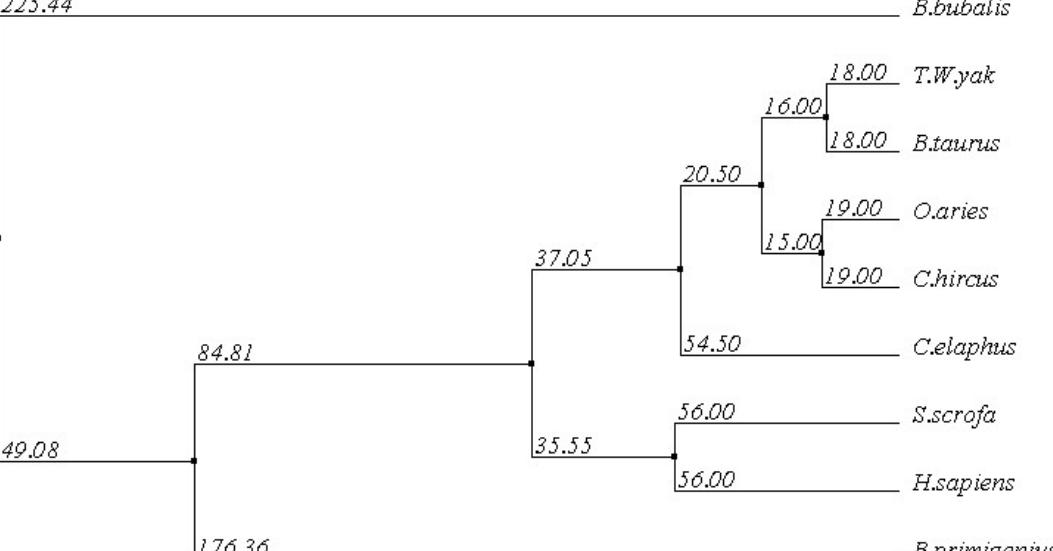
Figure 4. The phylogenetic tree of yak IGF2 and potentially related genes. The protein sequence of yak IGF2 was compared with other mammalian sequences of the GenBank data base. The alignment was generated with the BLOSUM 62 from MAFFT Multiple Sequence